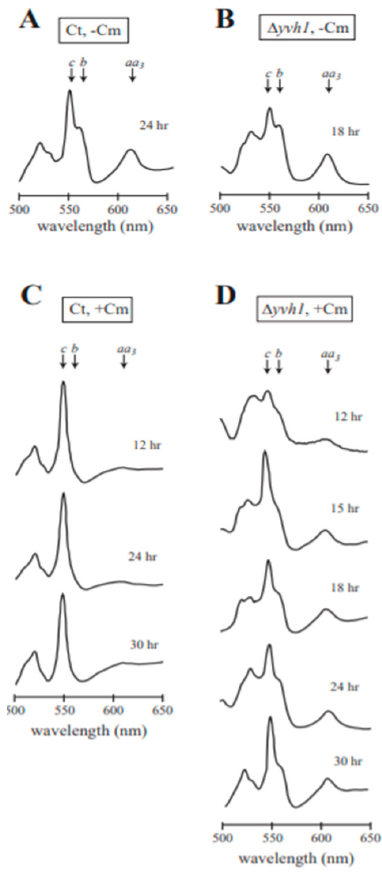
Figure 3. Cytochrome spectra. Qualitative cytochrome spectra of the NCN251 control (Ct) strain and the ∆ yvh1 strain, each grown in the absence ( A , B ) and presence ( C , D ) of Cm. The cytochrome content of mitochondria isolated from each culture was determined by scanning a reduced sample against an oxidized reference from 650 nm to 500 nm. The peaks indicated on the spectrum correspond to the absorbance maxima of cytochromes aa 3 (605 nm), b (560 nm) and c (550 nm). The time of growth is indicated for each spectrum.